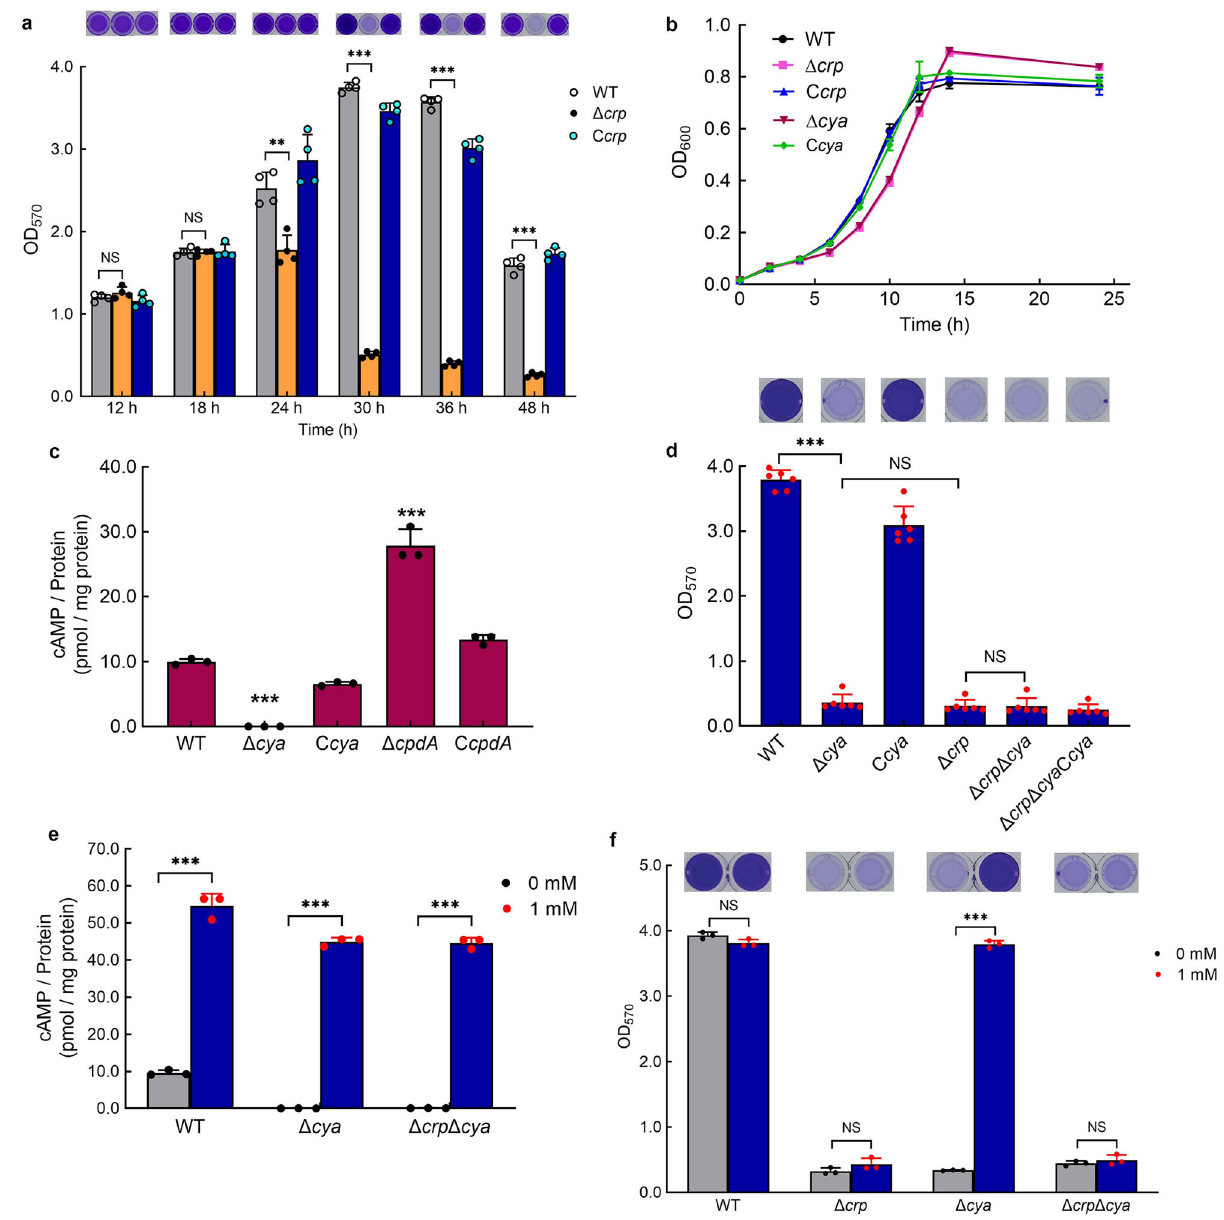
Fig. 2 cAMP-CRP complex supports bio fi lm maintenance in S. putrefaciens CN32. a Bio fi lm biomass ( n = 4 independent samples). b Cell growth ( n = 3 independent samples). c Intracellular cAMP concentration at 30 h ( n = 3 independent samples). d Bio fi lm biomass at 30 h ( n = 6 independent samples). e Intracellular cAMP concentration with the addition of 1 mM exogenous cAMP to the culture medium vs. control (no addition of exogenous cAMP [0 mM]) at 30 h ( n = 3 independent samples). f Bio fi lm biomass with the addition of 1 mM exogenous cAMP to the culture medium vs. control at 30 h ( n = 3 independent samples). Insets in ( a , d , f ) are the bio fi lm pictures of crystal violet dyeing. Data in ( a – f ) are shown as the mean ± SD.